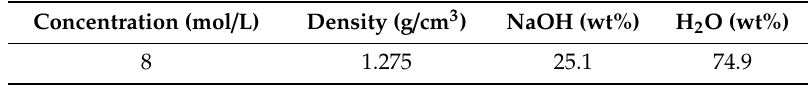
Table 4. Properties of NaOH solution. (Reproduced from the previous work [46] with permission from Elsevier).